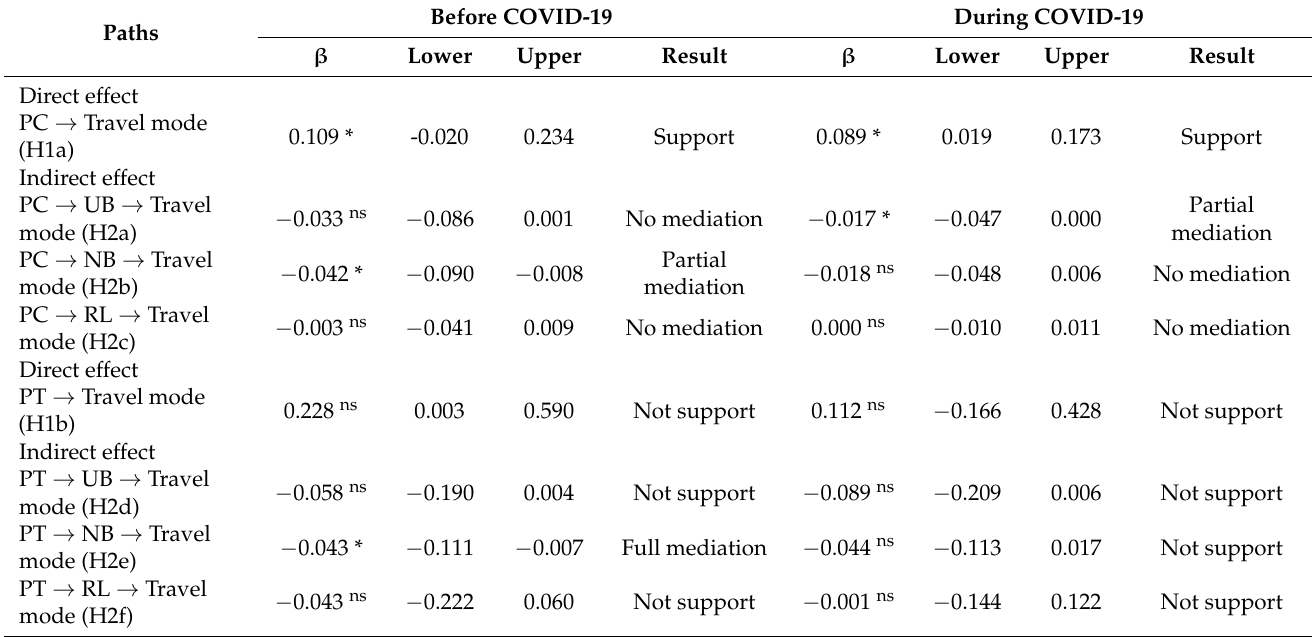
Table 6. Results of mediation